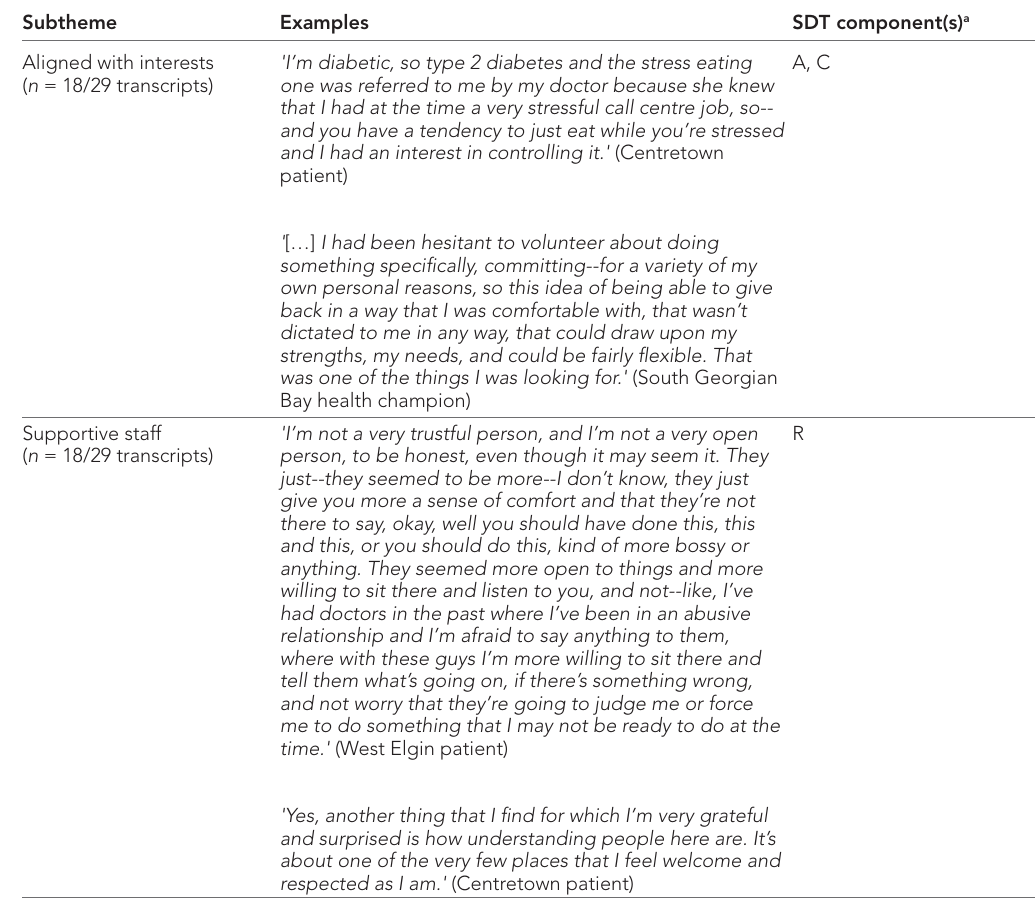
Table 3 Processes and relevance to self- determination theory components ( n = 18/29 transcripts)